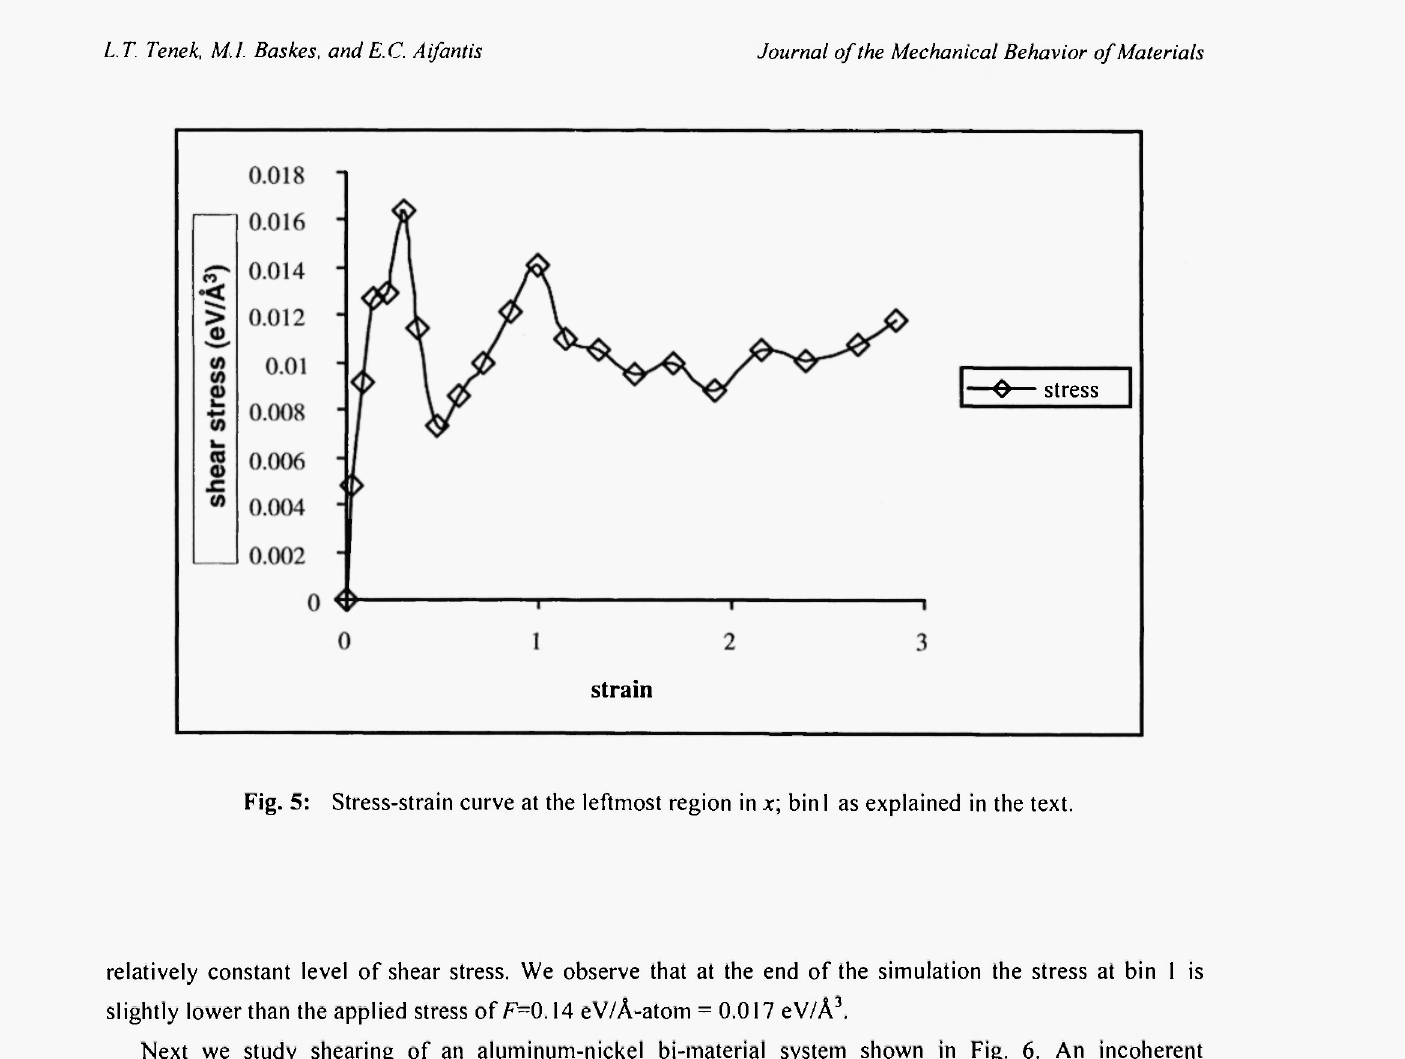
Fig. 5: Stress-strain curve at the leftmost region in χ; binl as explained in the